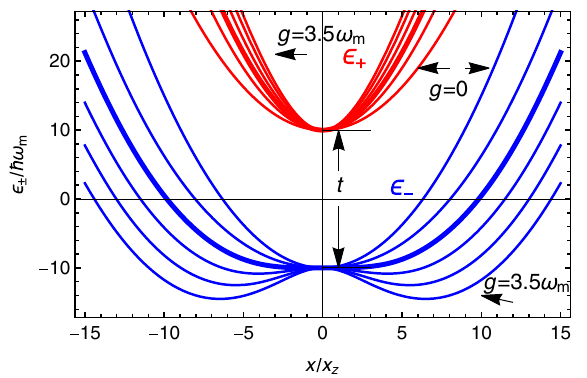
FIG. 2. Effective potentials ε Eq. (2) for t= ℏ ω 30, 40, 50, with the first and last lines explicitly indicated in the figure. The potential for g ¼ g sc thicker line.